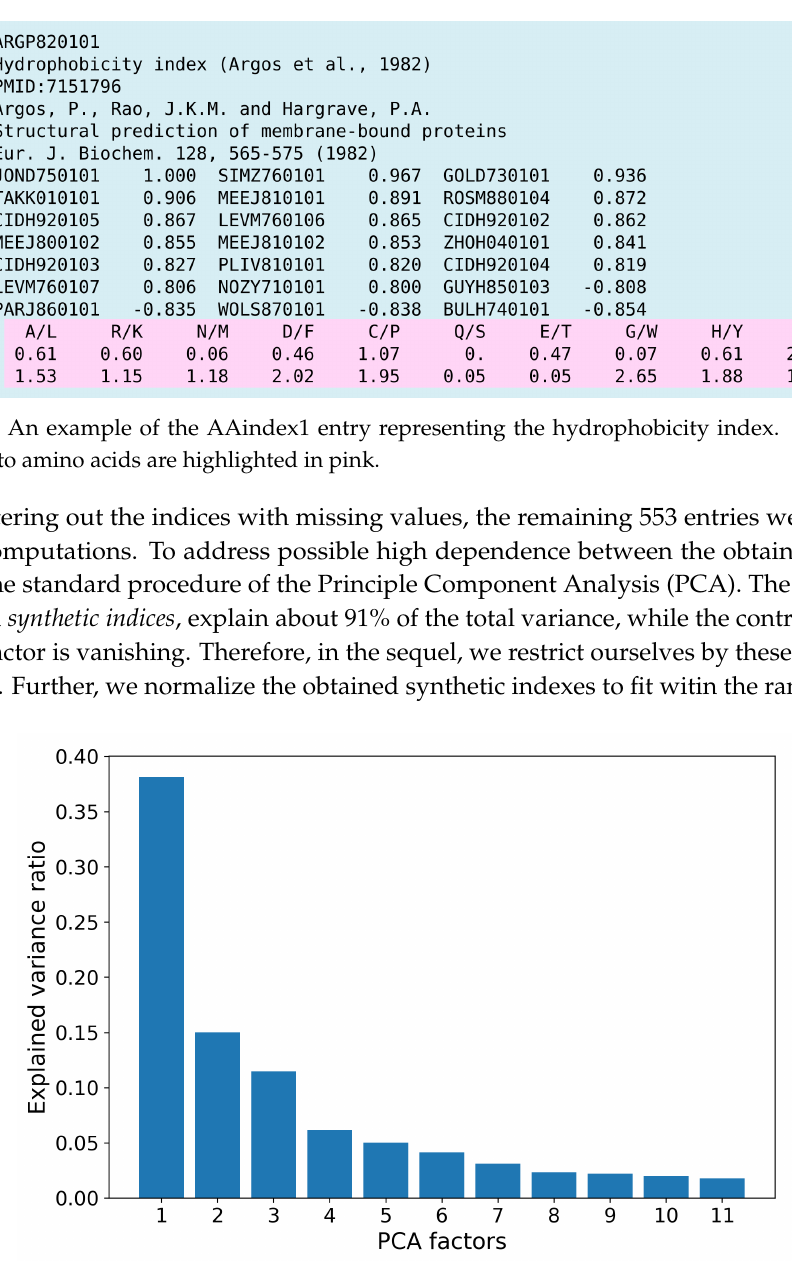
Figure 4. Variance ratios explained by the first 11 factors obtained with application the PCA to AAindex1 database. Total explained variance is about